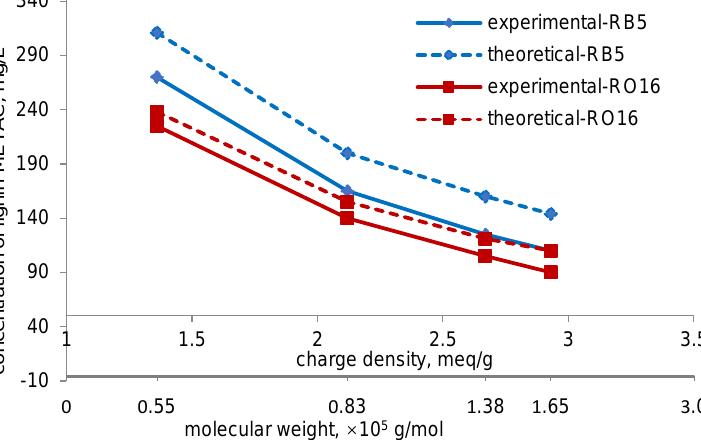
Figure 7. Relationship between charge density, MW, and optimum concentration of lignin-METAC copolymer in dye removal.